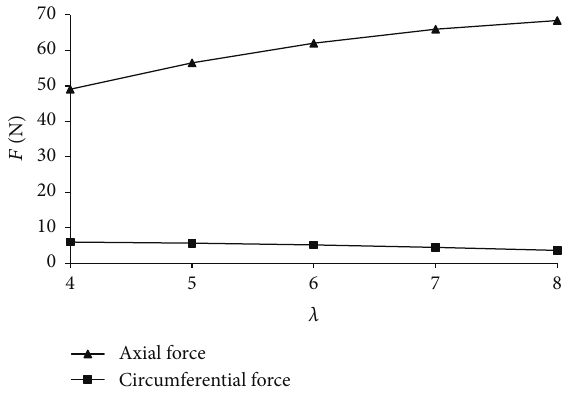
Figure 17: Variations of axial and circumferential forces with working